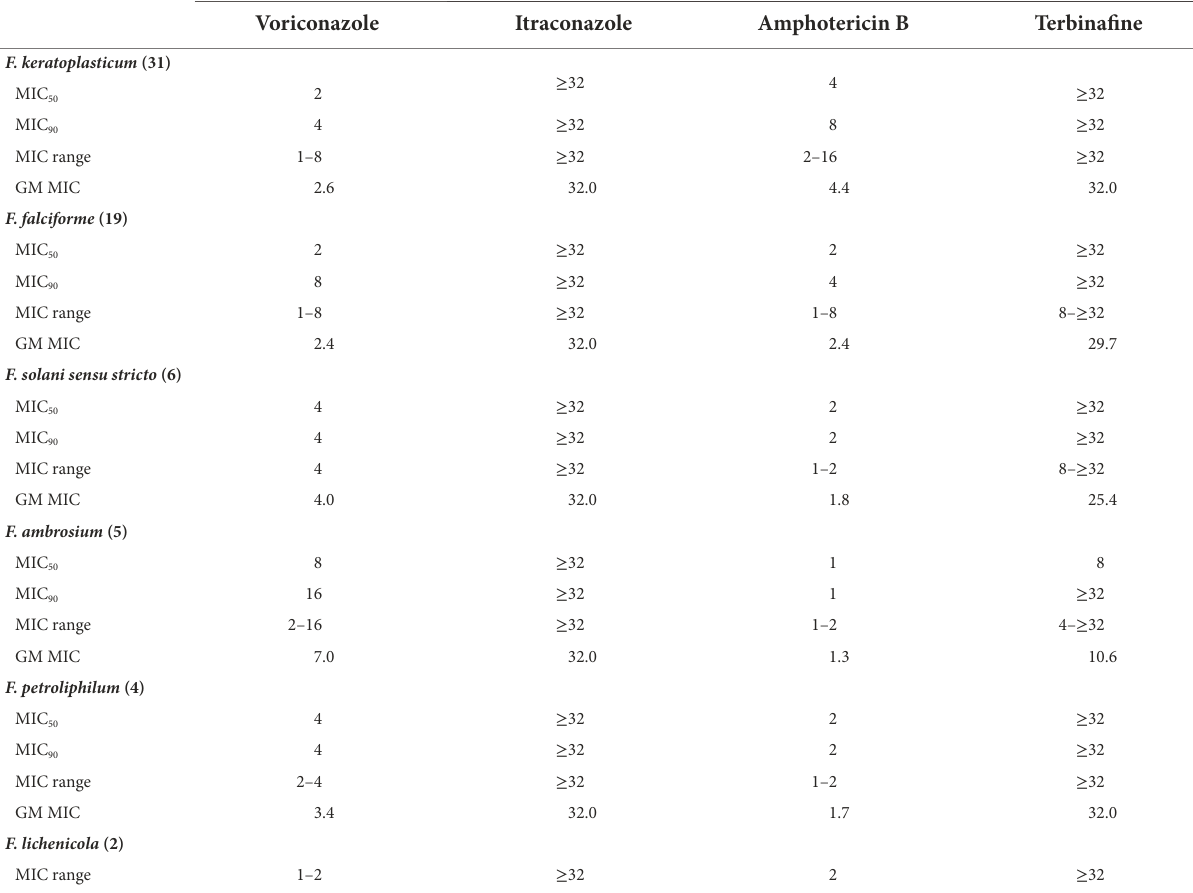
TABLE 3 Activities of antifungal agents against different species in F. solani species complex. Species